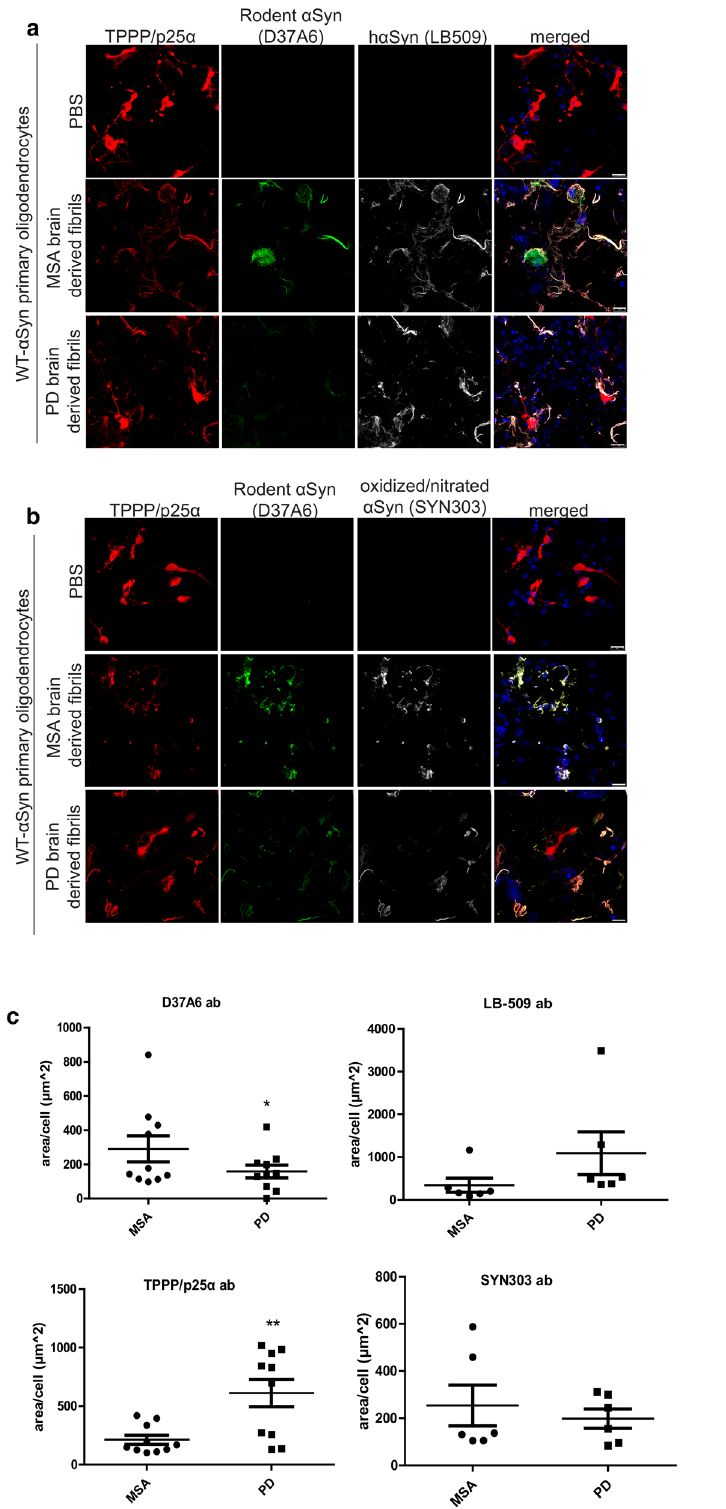
similar to other structures of α Syn lacking the same region 19